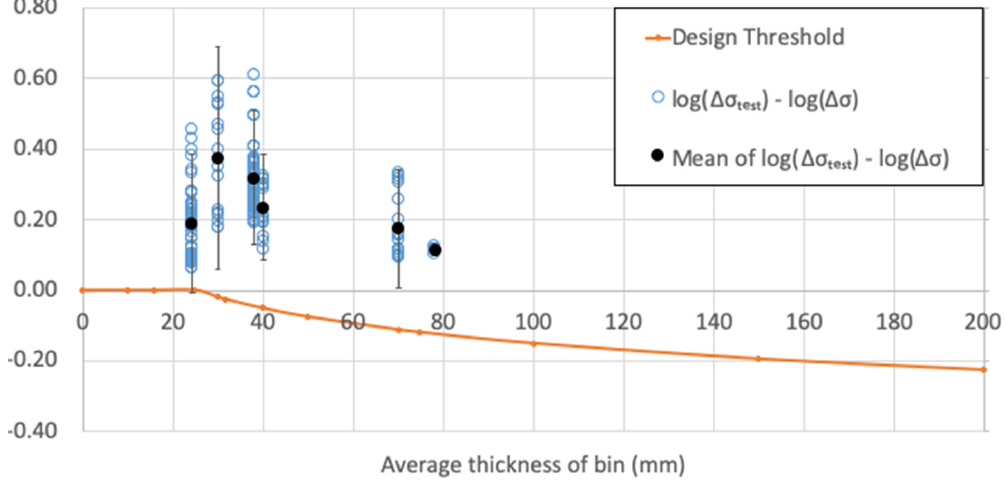
Figure 10. Data analysis of FC T-joints. Figure 12. Data analysis of FC T-joints . Figure 12. Data analysis of FC T-joints .